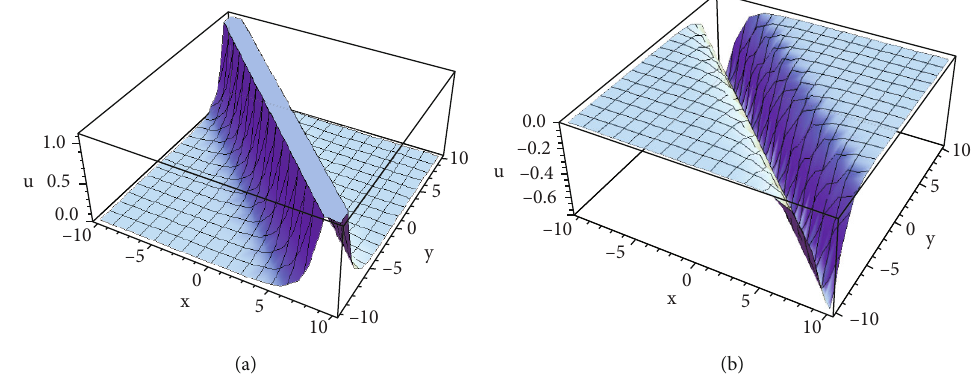
Figure 1: The outline of the bright soliton. (a) for Eq. (16) and (b) for Eq. (17).